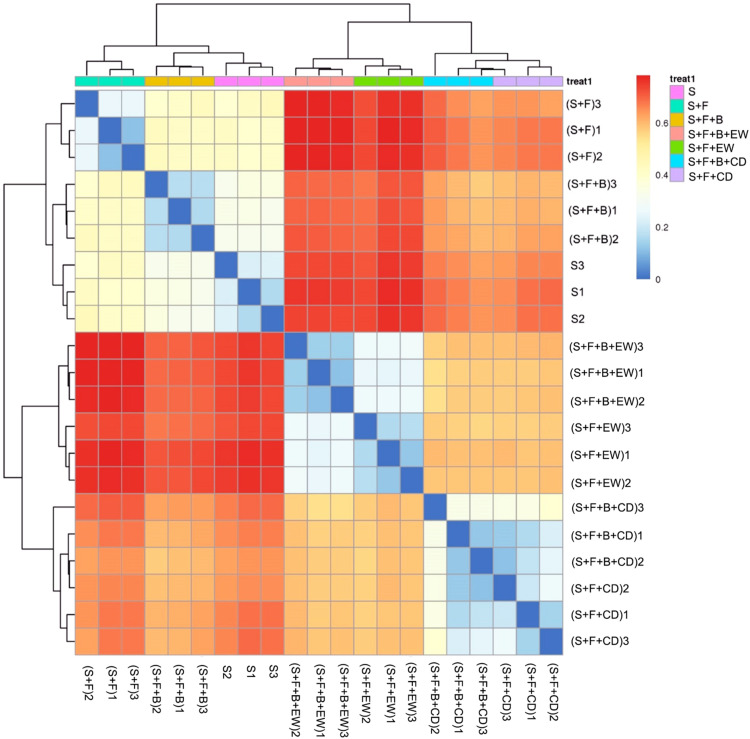
Heatmap of similarities between the bacterial communities based on Bray–Curtis distance indices in the different treatments. S, healthy control (healthy soil); S + F, disease control (healthy soil + FOC4); S + F + B, healthy soil + FOC4 + HN03 treatment; S + F + B + EW, healthy soil + FOC4 + HN03 + wormcast treatment; S + F + EW, healthy soil + FOC4 + wormcast treatment; S + F + B + CD, healthy soil + FOC4 + HN03 + cow dung compost treatment; S + F + CD, healthy soil + FOC4 + cow dung compost treatment. Every treatment has three replicates and was named treatment or (treatment) + numbers (1, 2, 3). The color gradient from red to blue indicates increasing similarity. Panels within the figures indicate the similarity among soil samples.